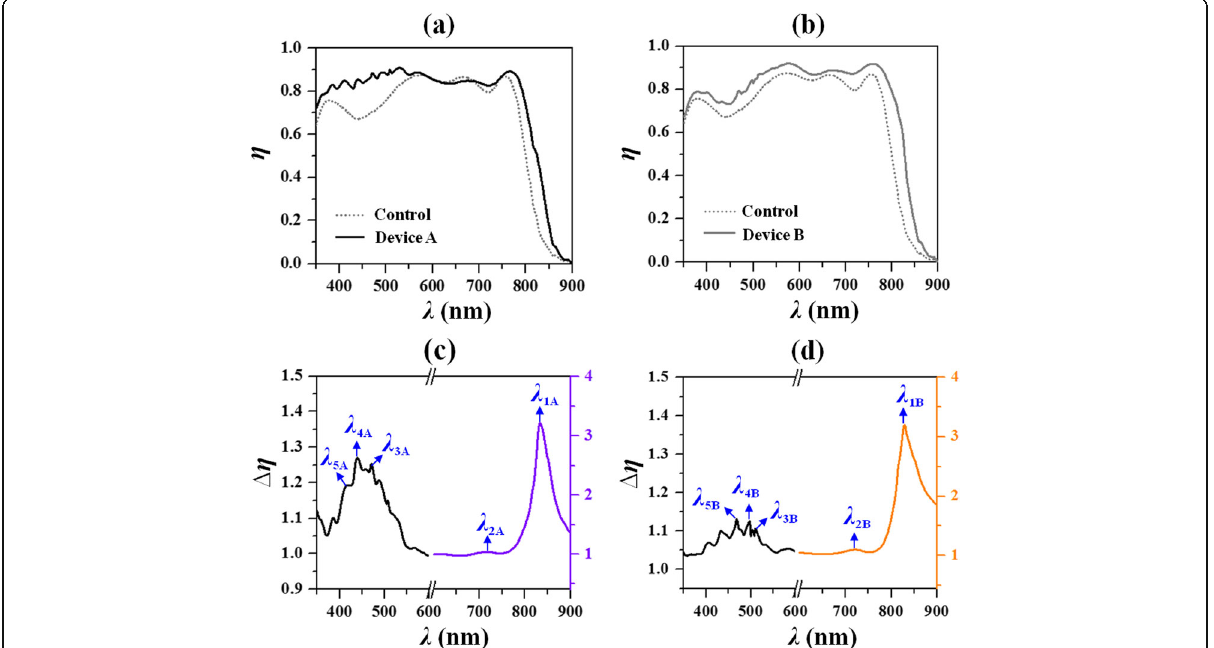
Fig. 3 a Absorption spectra in the active layer (solid) for Device A ( a ) and Device B ( b ) with respect to that of the planar control (dashed). Spectra of relative absorption change for Device A ( c ) and Device B ( d ). Five enhancement peaks are labeled in c with λ 1A =830 nm, λ 2A =724 nm, λ 3A =470 nm,